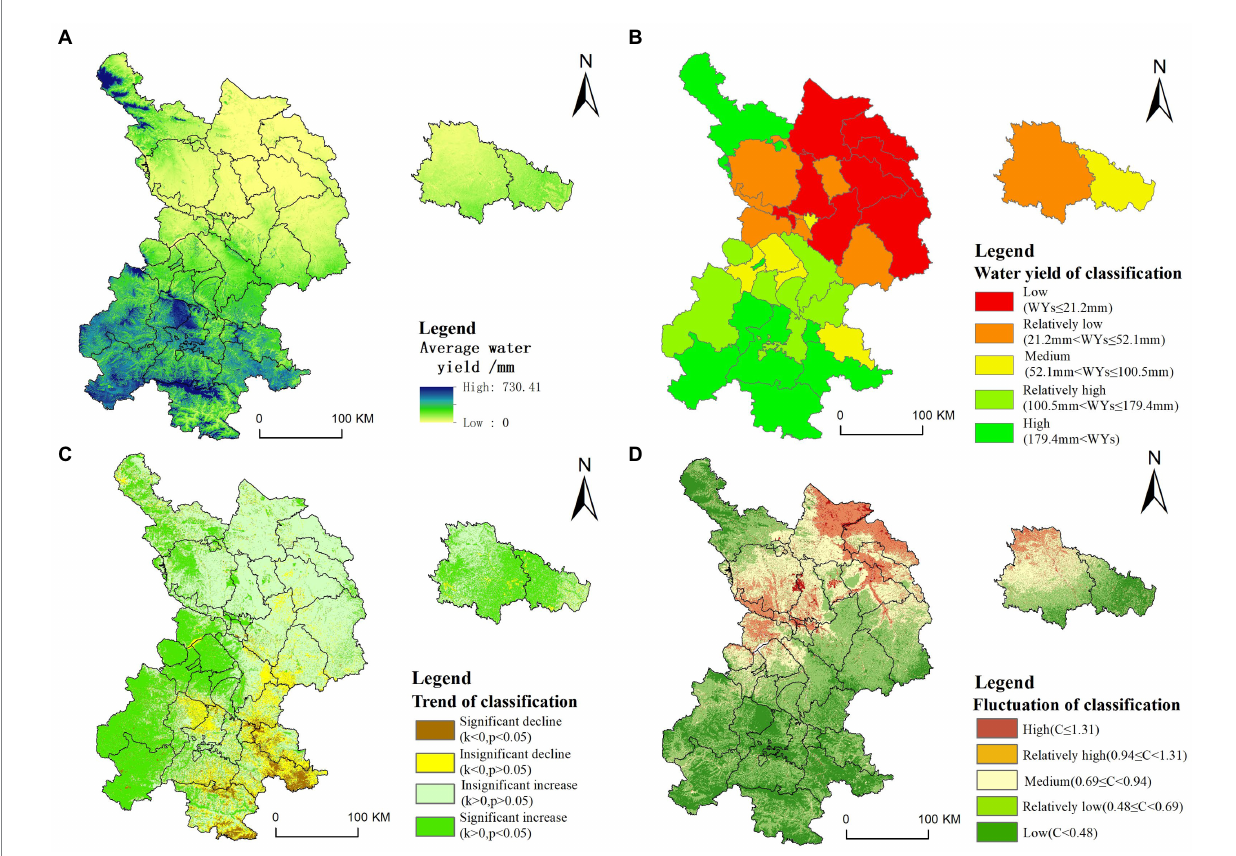
FIGURE 4 Spatial distribution characteristics and change rules of WYs. It shows the spatial distribution of the average WYs from 2000 to 2020 (A) , and the statistics of WYs based on the county-level administrative units (B) . Due to the large interannual variation of WYs, in order to intuitively display the spatial regularity of WYs over a long period of time, we have carried out trend analysis (C) and coefficient of variation calculation (D)